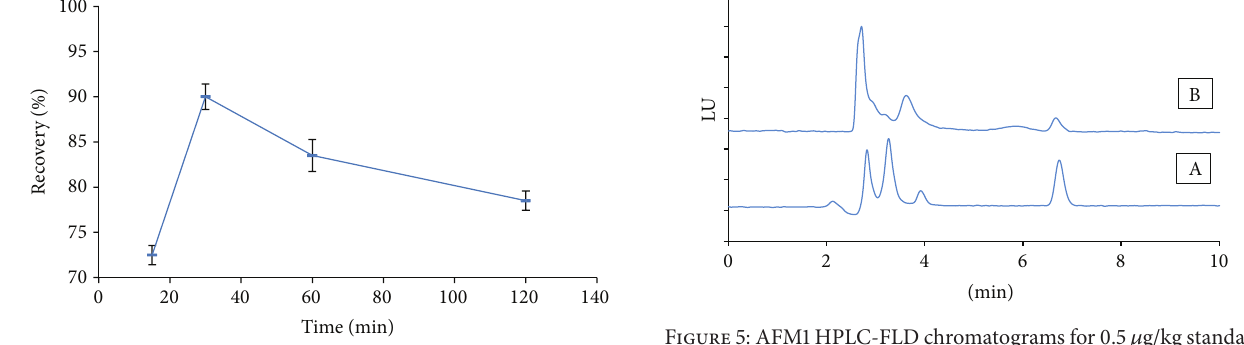
Figure 3: Effect of various times of incubation on AFM1 recovery (mean ± SD, 𝑛 = 2 ).